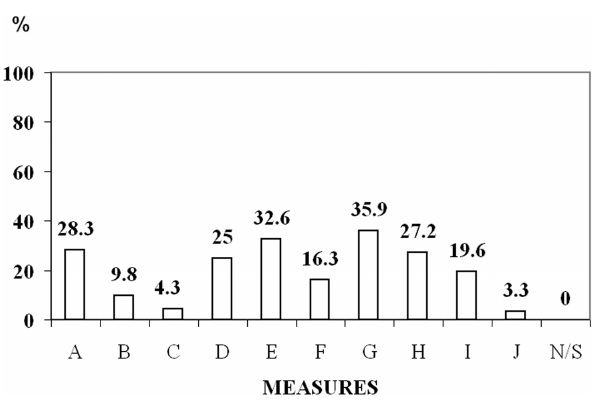
Fig. 10. Preferences for different management measures. Unaf- fected temporal residents.